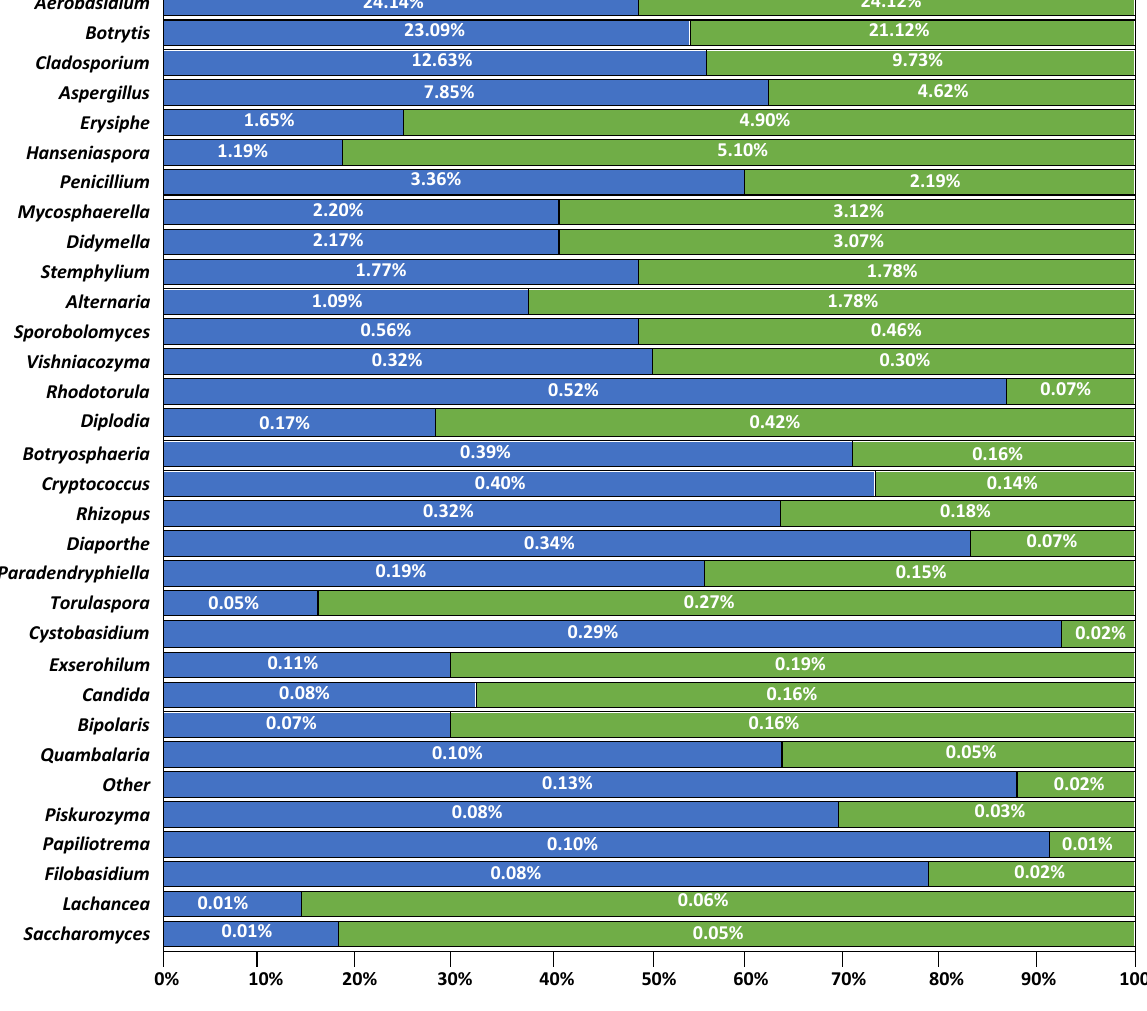
Figure 5. Abundance percentage of each genus among Cabernet Sauvignon cultivars (blue bars) and local cultivars (green bars). In white, the percentage of abundance of that genus for the Cabernet Sauvignon cultivar and local cultivars.